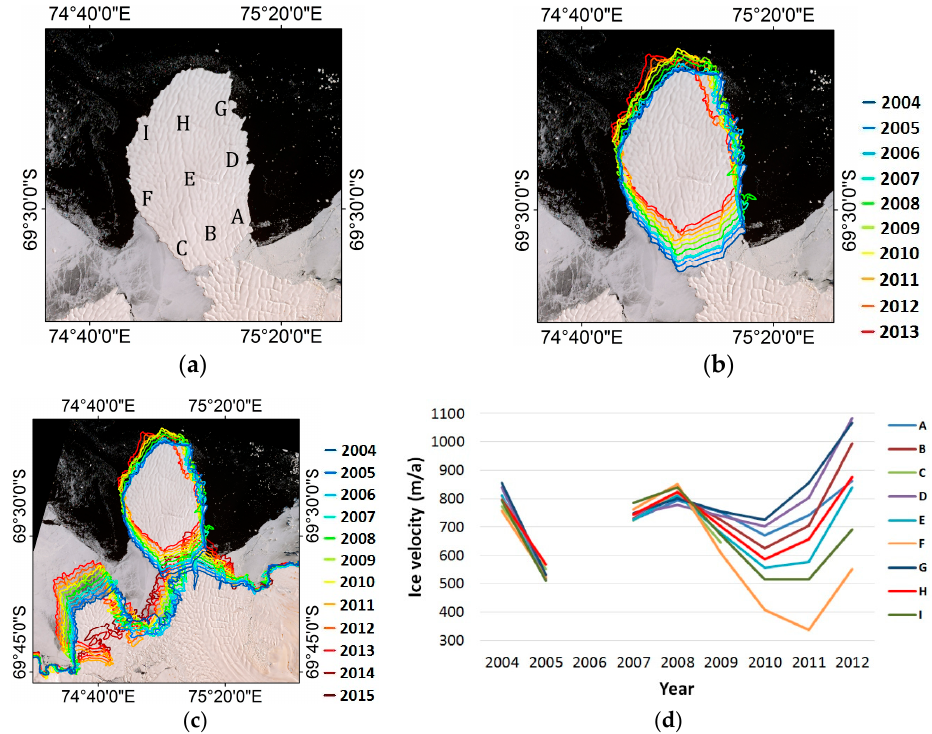
Figure 12. Annual contour lines and multi-temporal velocities of the calved iceberg. ( a ) Nine uniformly distributed points named “A” to “I” were chosen on the PRG; ( b ) Annual contour lines shown in different colors; ( c ) Annual contact points of the PRG and the calved iceberg shown in different colors; ( d ) Annual ice velocities of the different points.